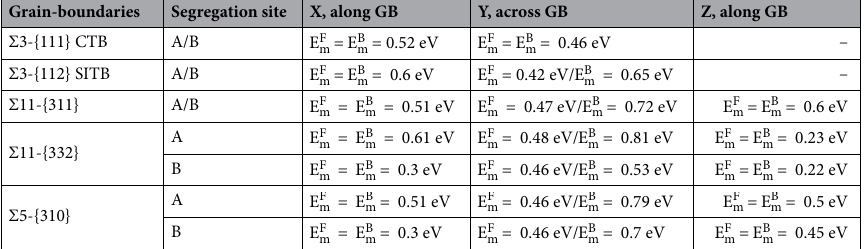
Table 1. Energy barriers for the most stable segregation position A and the highest volume position B along the different directions X; Y and Z. The forward ( E